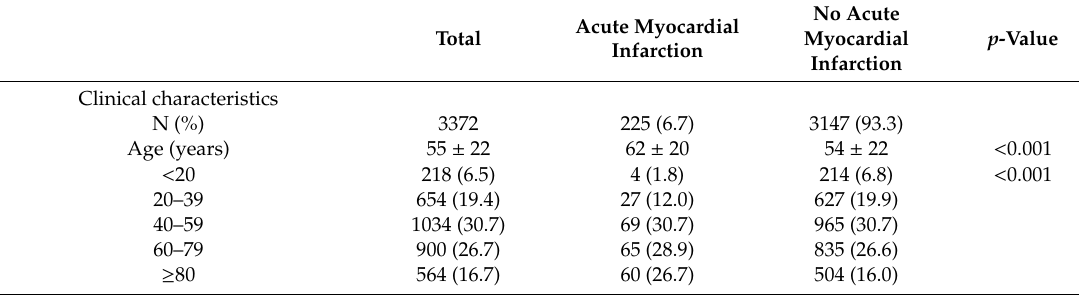
Table 1. Clinical characteristics, in-hospital treatments, complications, outcomes, and resource utilization in heat stroke